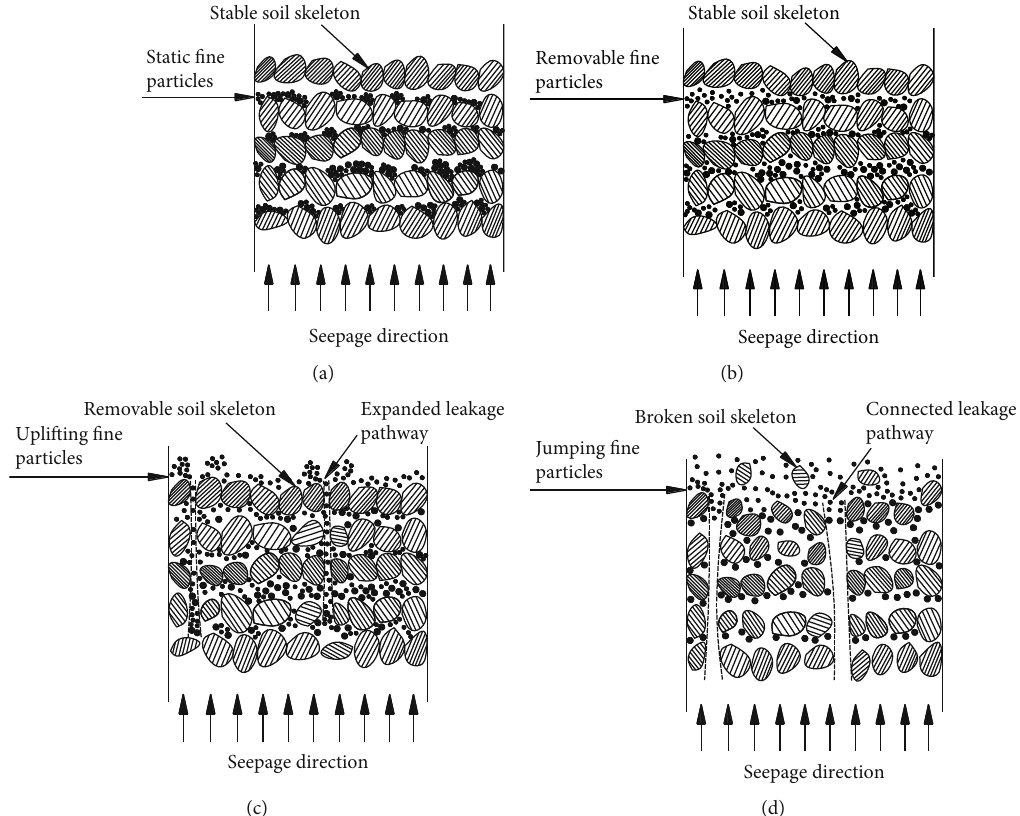
Figure 18: Schematic illustration of the entire seepage failure process observed in the experimental modelling: (a) incubation, (b) formation, (c) evolution, and (d)